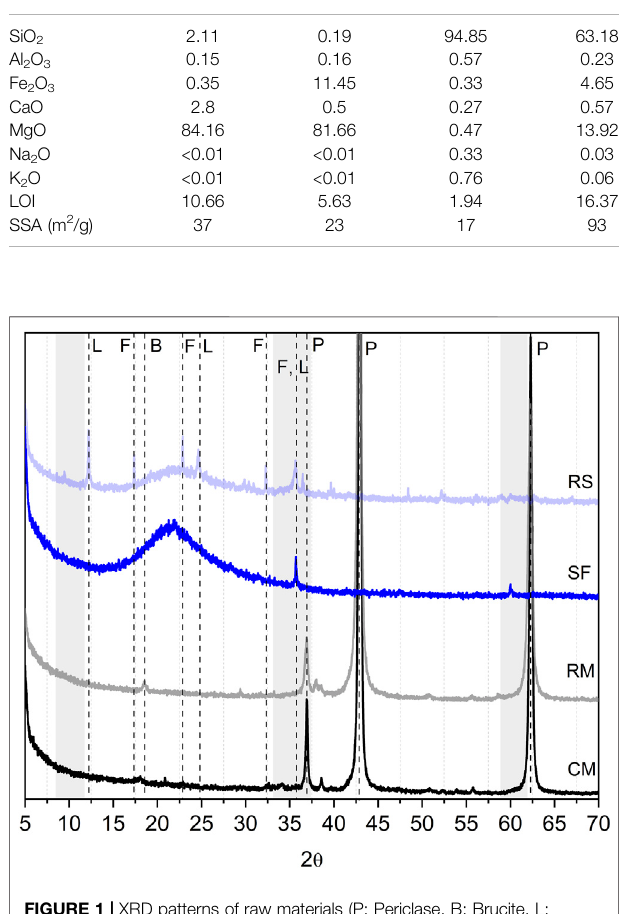
FIGURE 1 | XRD patterns of raw materials (P: Periclase, B: Brucite, L: Lizardite, F: Forsterite).